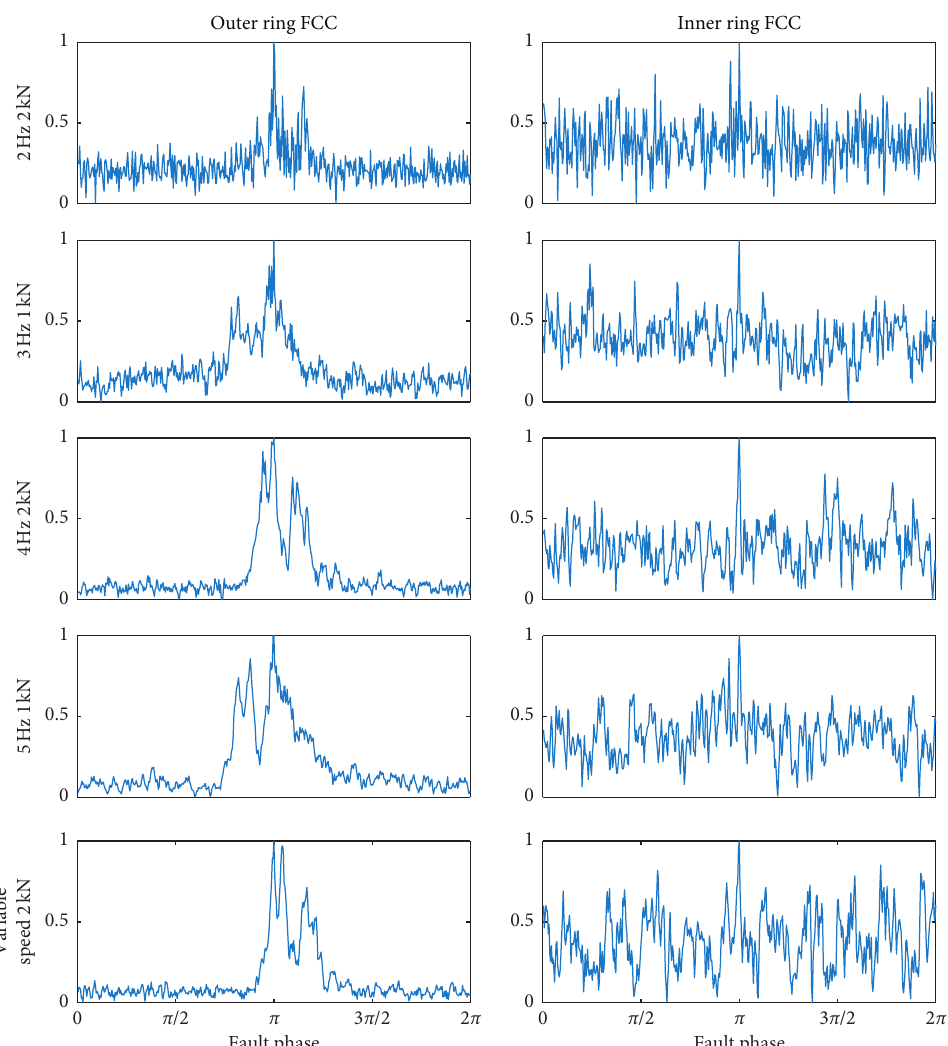
Figure 13: Feature extraction results of 1.1mm outer ring fault under different working